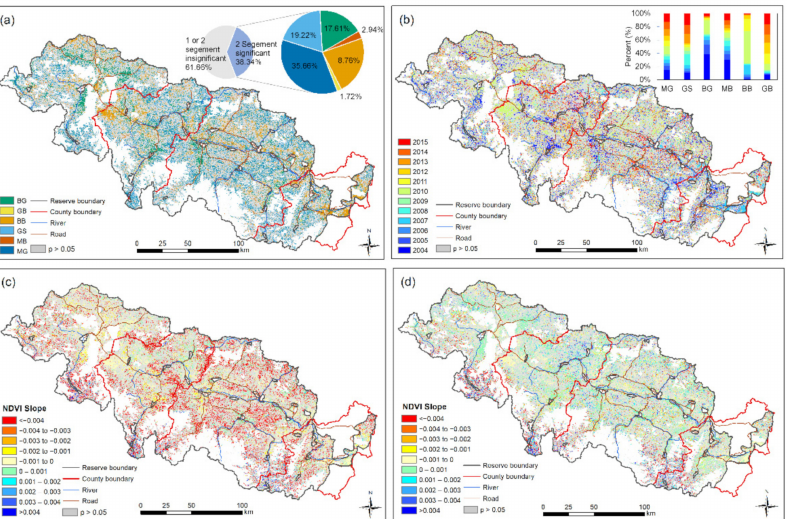
Figure 5. Spatial variation in the shifts in the NDVI ( a ), corresponding year ( b ) of the QNNP (2000–2018), trend of NDVI before shift ( c ), and its trend after shift ( d ). The inset in ( a ) represents the percentage of each shift type, and that in ( b ) depicts the percentage of shift times detected for each shift type. Abbreviations: MG, monotonic greening; GS, greening with setback; BG, browning to greening; MB, monotonic browning; BB, browning with burst; GB, greening to browning. Non- vegetation areas were masked out by white color.